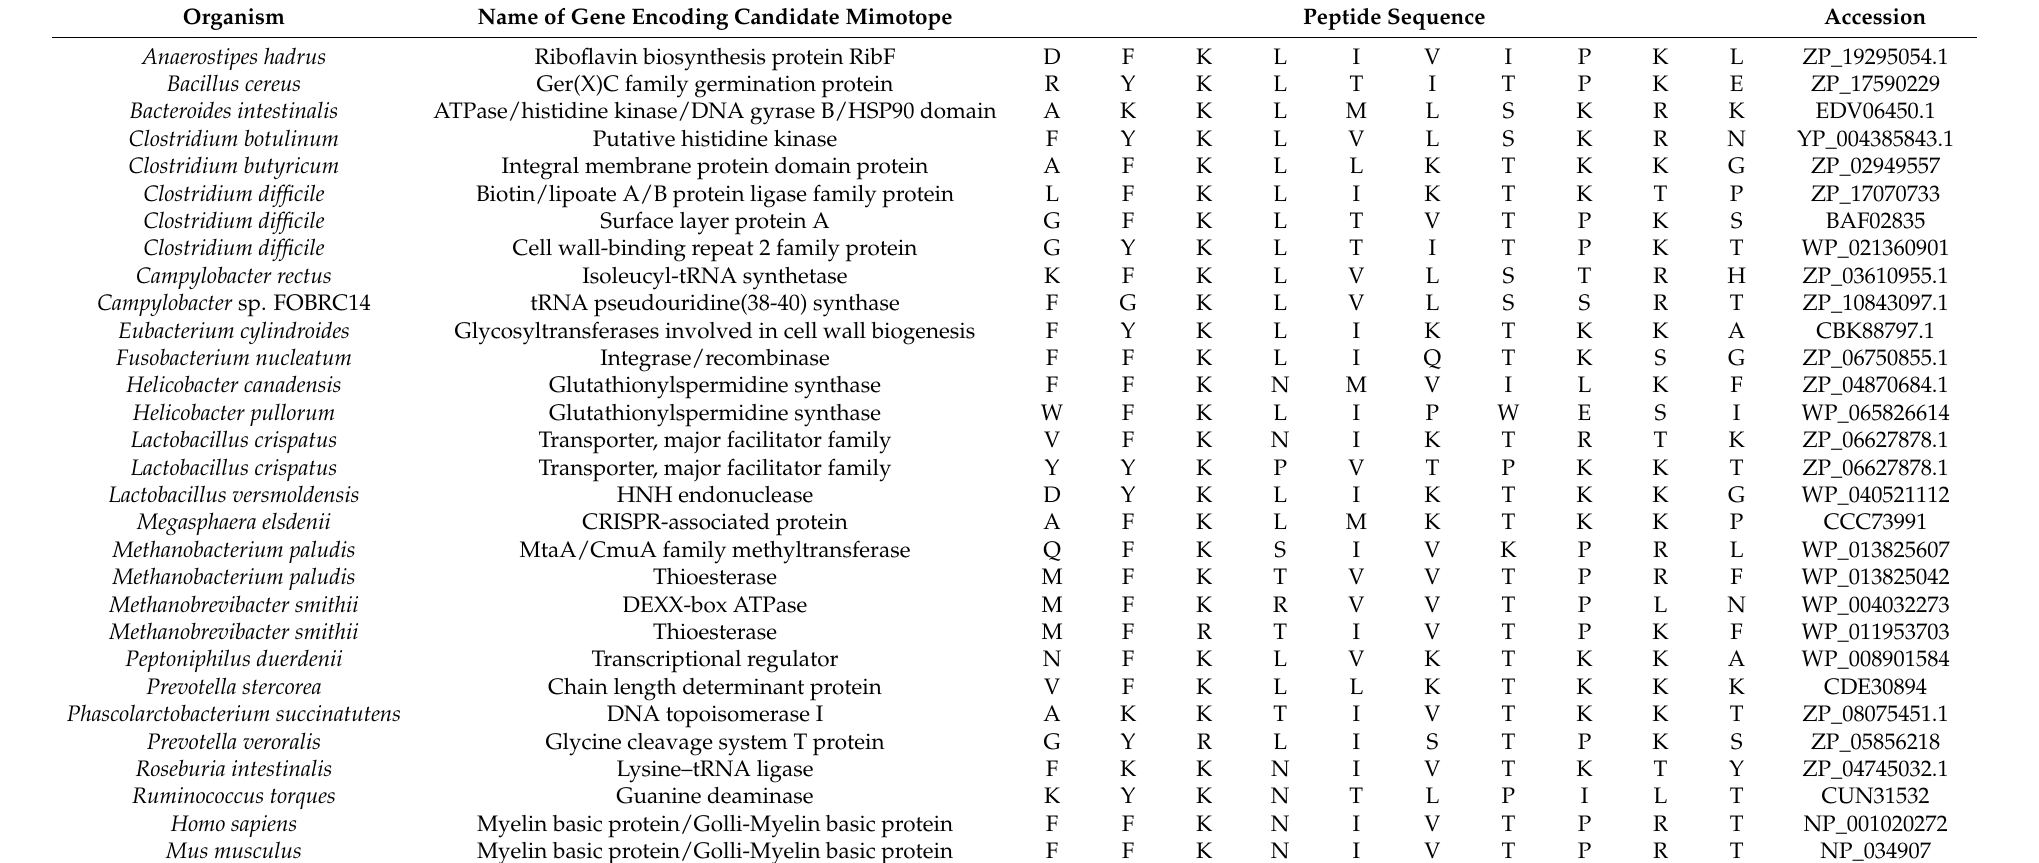
Table 1. Candidate peptide mimotopes of gut